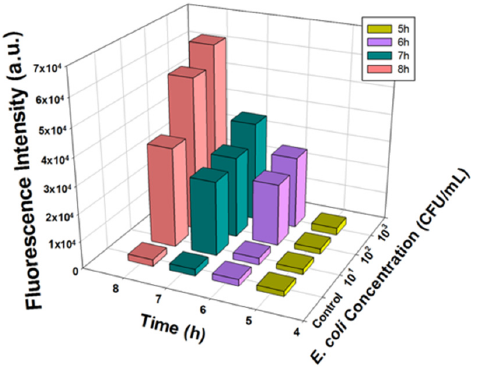
Figure 5. Fluorescence intensity measured from T7 lacZ phages infecting E. coli in beef juice at varying concentrations (0, 10, 10 2 , 10 3 , 10 4 , and 10 5 CFU/mL) after incubating for 5, 6, 7 and 8 h at 37 ° C. Data represent the means of a minimum of three independent replicates.